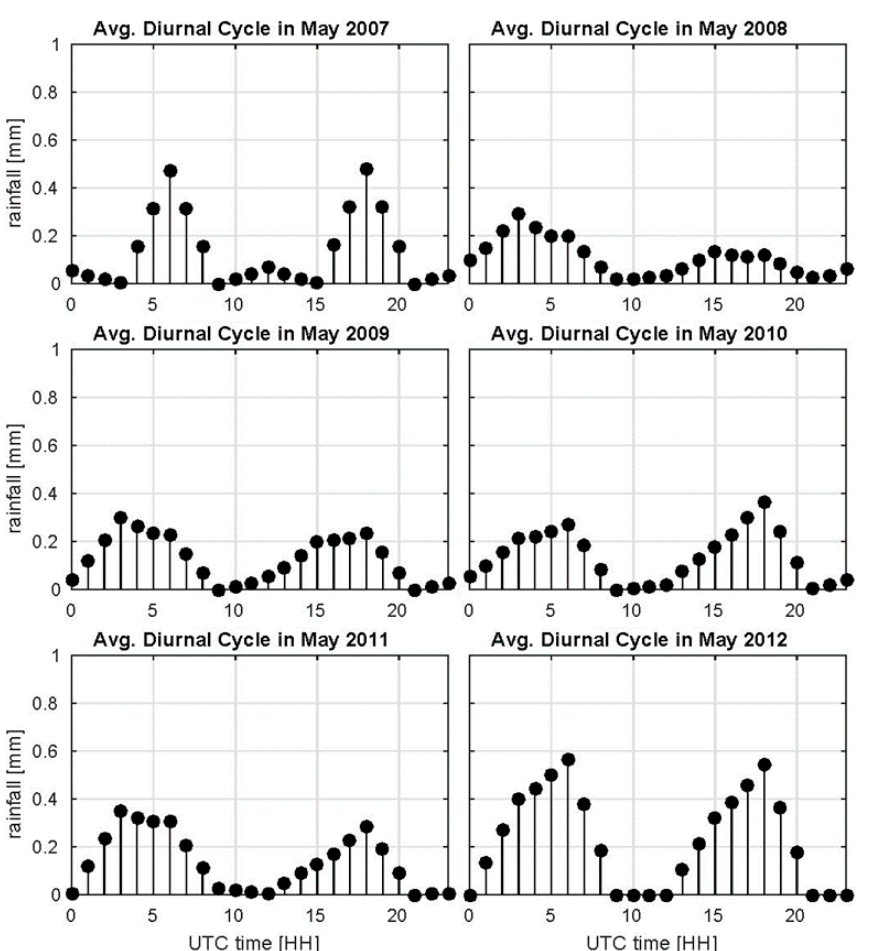
Figure 12. Average diurnal cycle of TRMM 3B42 rainfall accumulations for the month of May. The diurnal cycle is marked by a bi-model precipitation pattern with peaks in morning and evening. Only pixels within the midland area marked by Figure S1 with monthly rainfall totals greater than 25 mm/month were considered for this analysis.